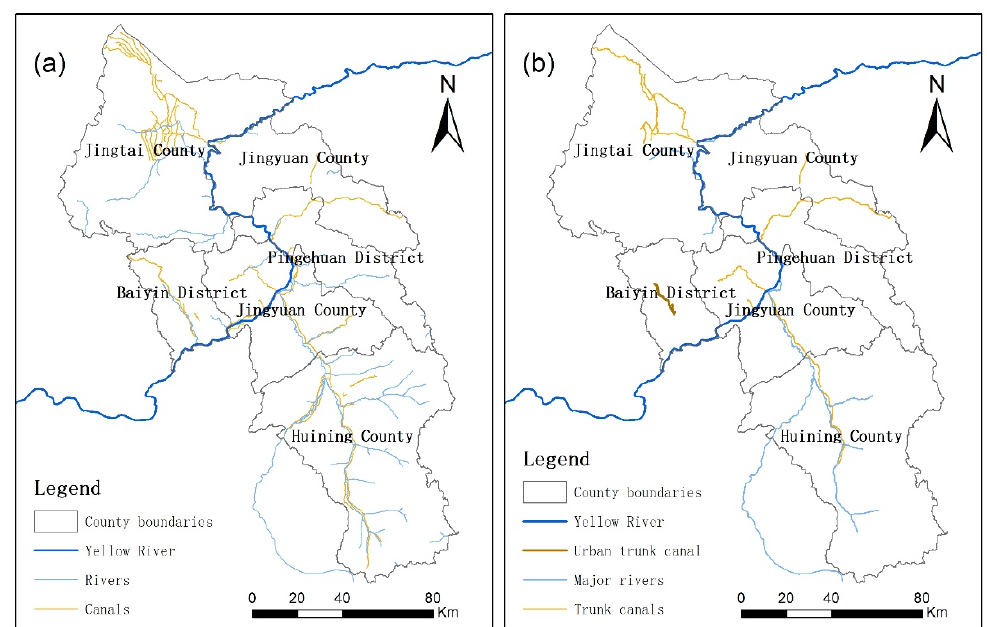
Figure 3. ( a ) Irrigation water supply sources; ( b ) Urban water supply